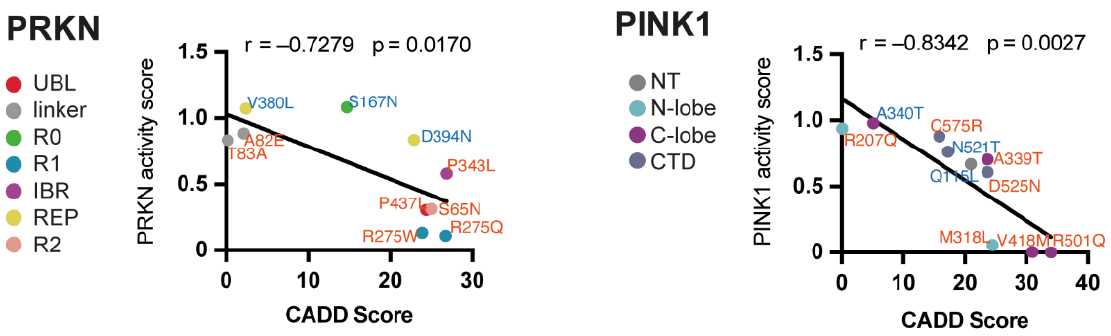
Figure 5. Correlation of functional activity with CADD score. Linear regression of composite activity scores for variants were based on the average of pS65-Ub Western blot, immunofluorescence signal and PRKN translocation (PRKN) or pS65-Ub Western blot levels (PINK1) show a significant and strong negative correlation with CADD scores for both, PRKN and PINK1.